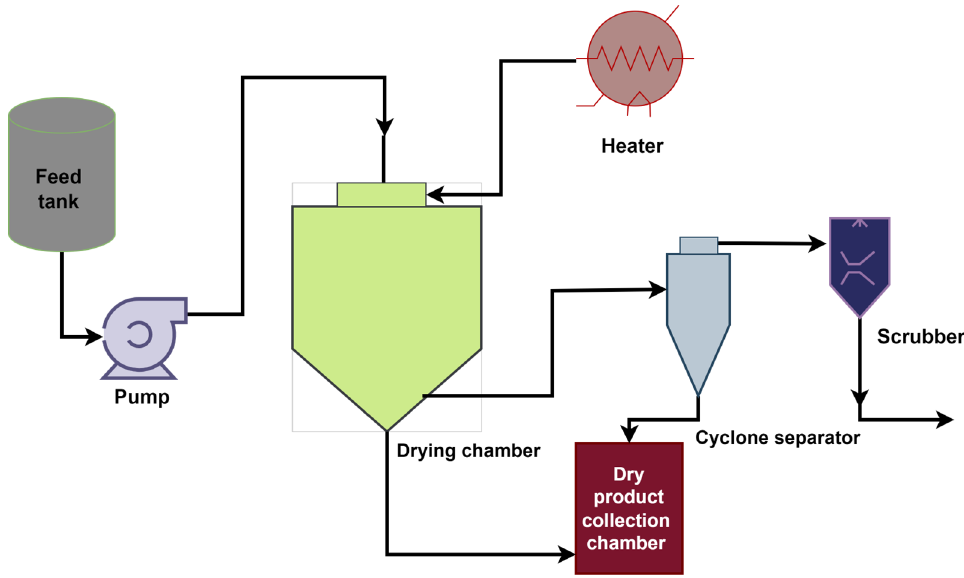
Figure 4. Spray dryer working procedure.